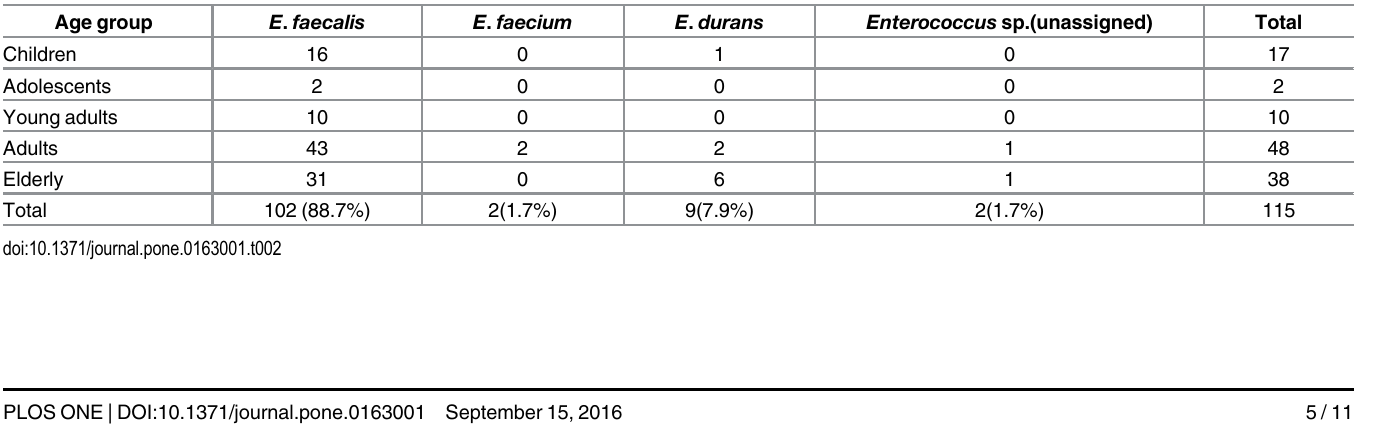
The species distribution of enterococci in each group is shown in Table 2. Of the 115 entero- coccal isolates, overall the most predominant were E . faecalis (88.7 per cent) followed by E . dur- ans (7.9%) and E . faecium (1.7%). E . faecalis carriage for children, adults and elderly were 94.1%, 89.5%, 81.6%, respectively. E . durans was the second most frequently isolated species representing 7.9% of the isolates. The latter was most frequently found in elderly patients (15.8%), followed by adults (4.2%) and children (5.96%). E . durans was not isolated from either adolescents or young adults. A very low prevalence of E . faecium was noted in adults with only two isolation events (1.7%). We also noted marked differences when the identical isolate was phenotyped by the API 20 Strep system and genotyped by rDNA sequence analyses, with 21.7% (25 of the total) of isolates being assigned to two different species (Table 3). For instance, the genotype E . faecalis was identified by API 20 Strep system as E . avium , E . durans , E . faecium in 14 analyzed samples, whilst the genotype E . durans was identified as E . faecalis and E . faecium by API 20 Strep on two occasions. We therefore used the rDNA sequence analyses results as definitive information for the current study.